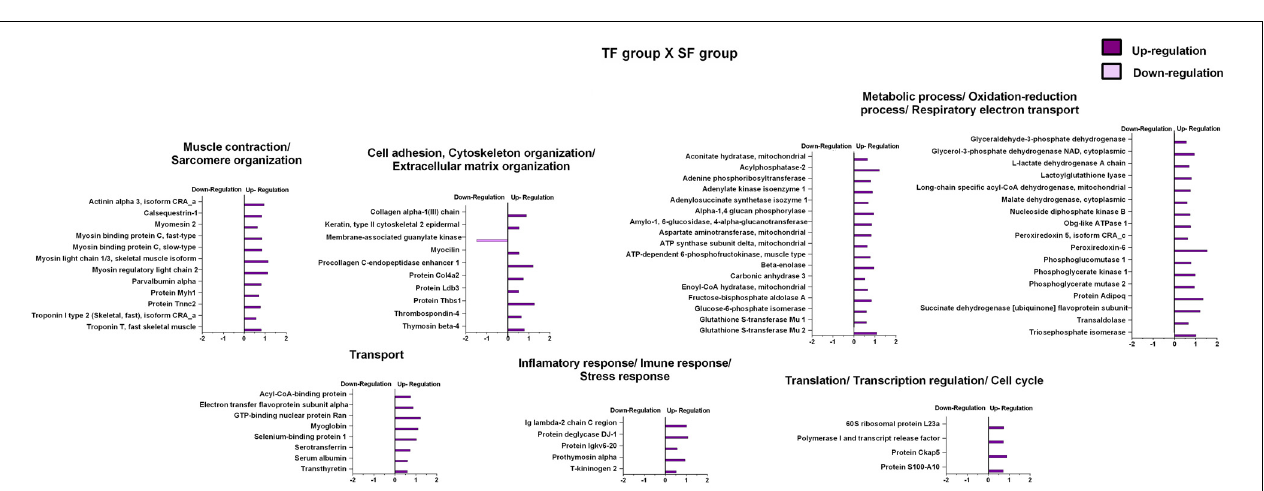
FIGURE 4 | Effects of resistance training on father tendon proteome. Analysis of proteins from the tendons of the trained versus control animals (fathers). Histogram of protein abundance levels from intergroup analysis considering only proteins with down-regulation and up-regulation ( p ≤ 0.05), with a ln(fold change) of at least ( ≥ ) 0.5. SF, sedentary fathers; TF, trained fathers. The X -axis represents the natural logarithm of the ratio between the treatments (purple: TF:SF ratio ). All altered proteins are grouped according to their biologic process as noted in Gene Ontology (GO). The proteins were considered reliably identified only if presenting an FDR < 1% and at least two matching peptides. Supplementary Data 3 shows detailed information about each protein outlined in this